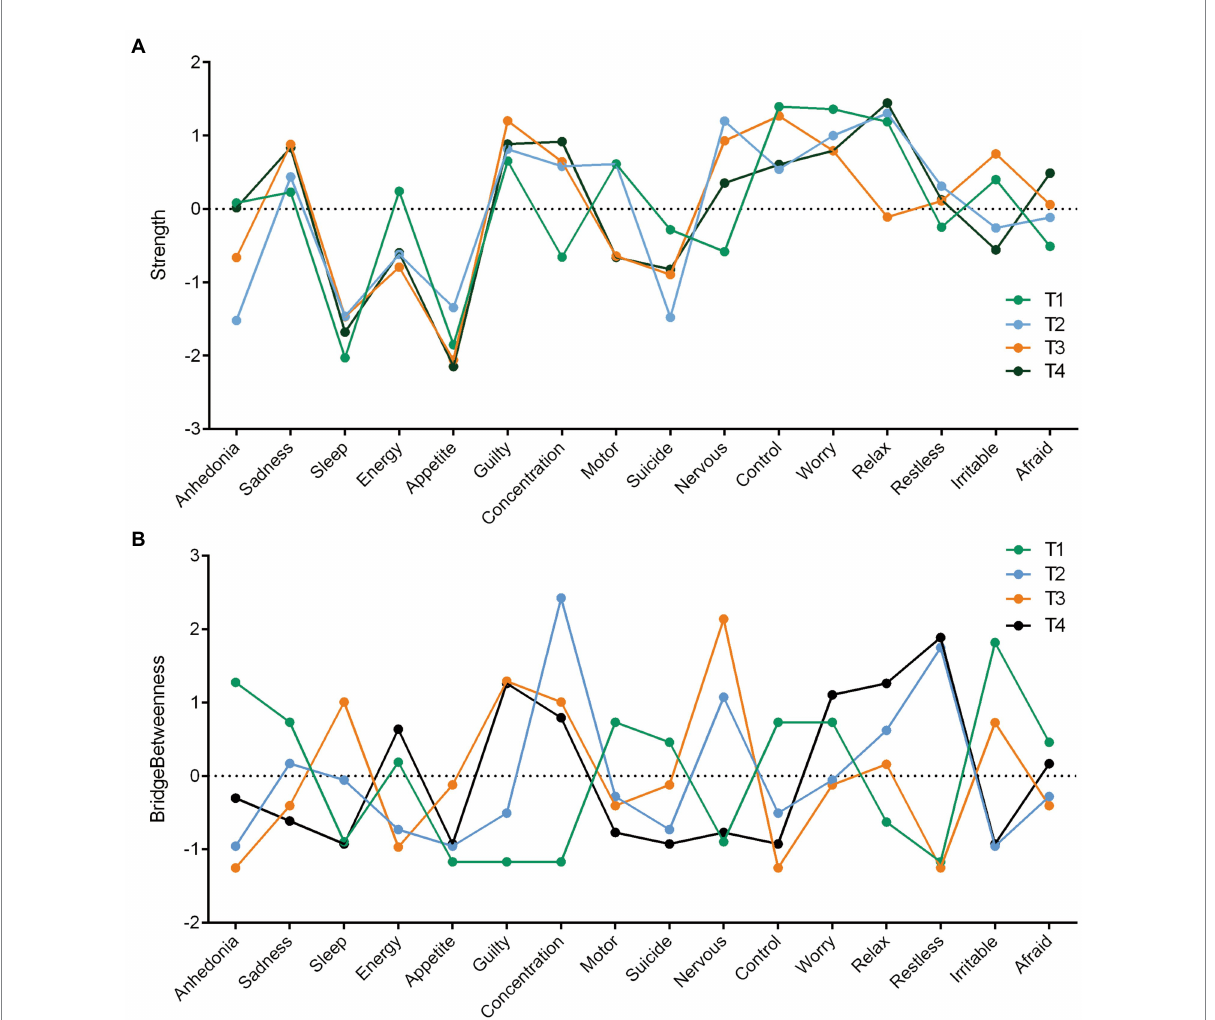
FIGURE 2 Nodes Strength and Bridge Betweenness Centrality Estimates for the PHQ-9 Items and the GAD-7 Items Completed at T1, T2, T3 and T4. Figure 2 A depicts nodes strength centrality, and Figure 2 B depicts nodes bridge betweenness centrality. PHQ-9: Patient Health Questionnaire-9; GAD-7: Generalized Anxiety